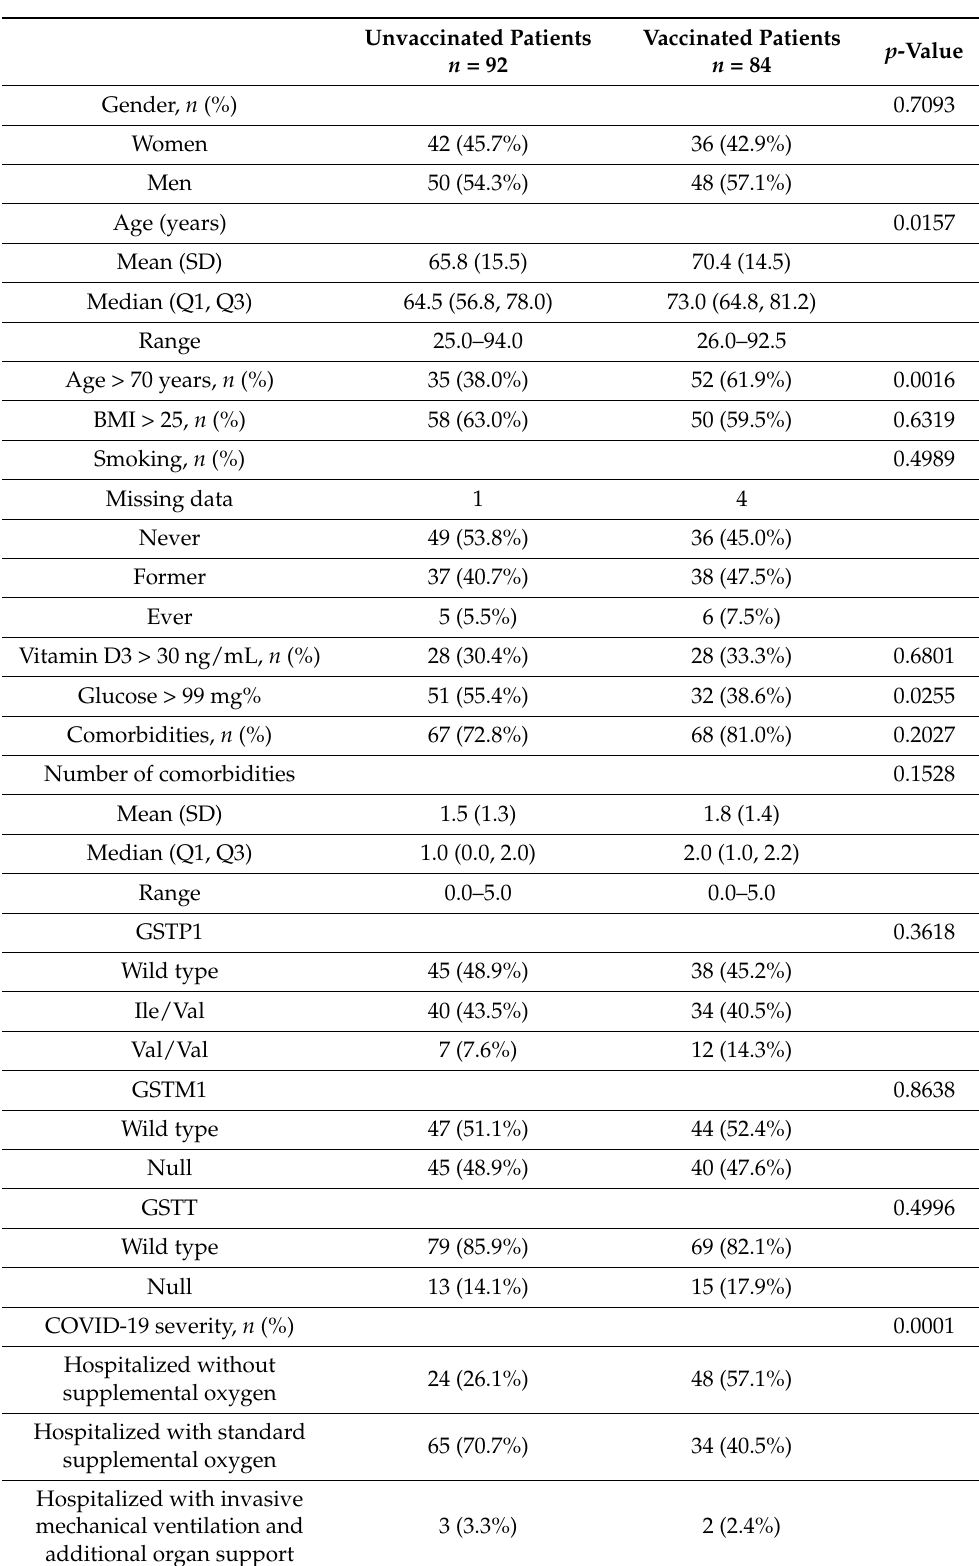
Table 1. Baseline characteristics of patients included in the